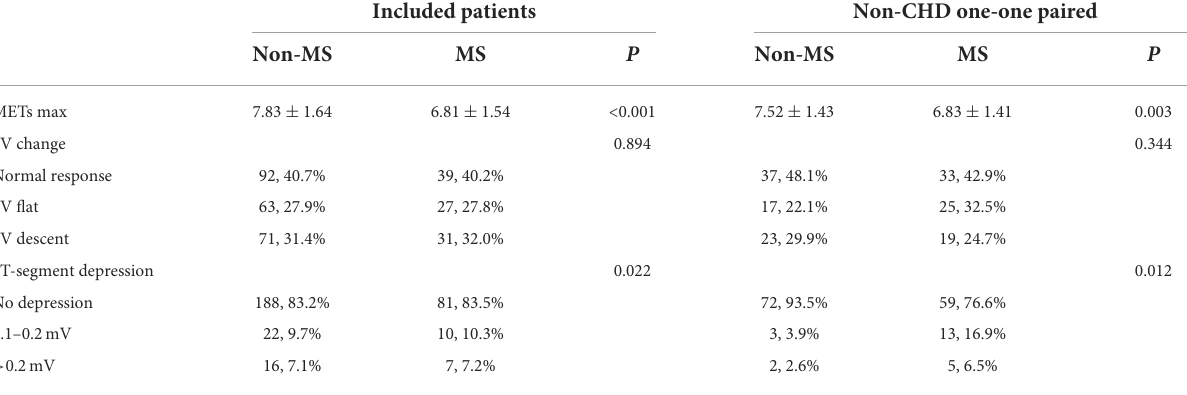
TABLE 4 The distribution of SV change types and ST-segment depression of included patients and non-CHD one-one paired. Included patients Non-CHD one-one paired